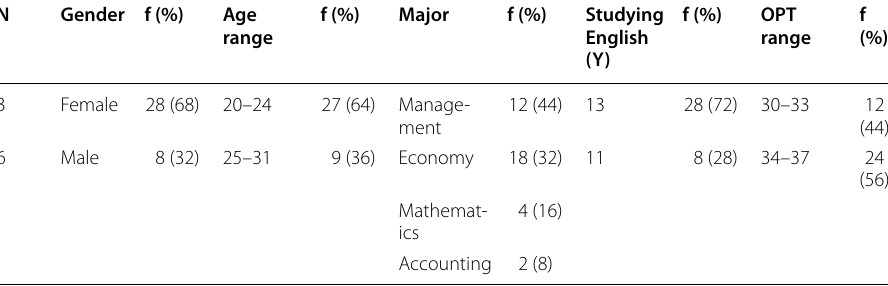
Table 1 Demographic attributes of the